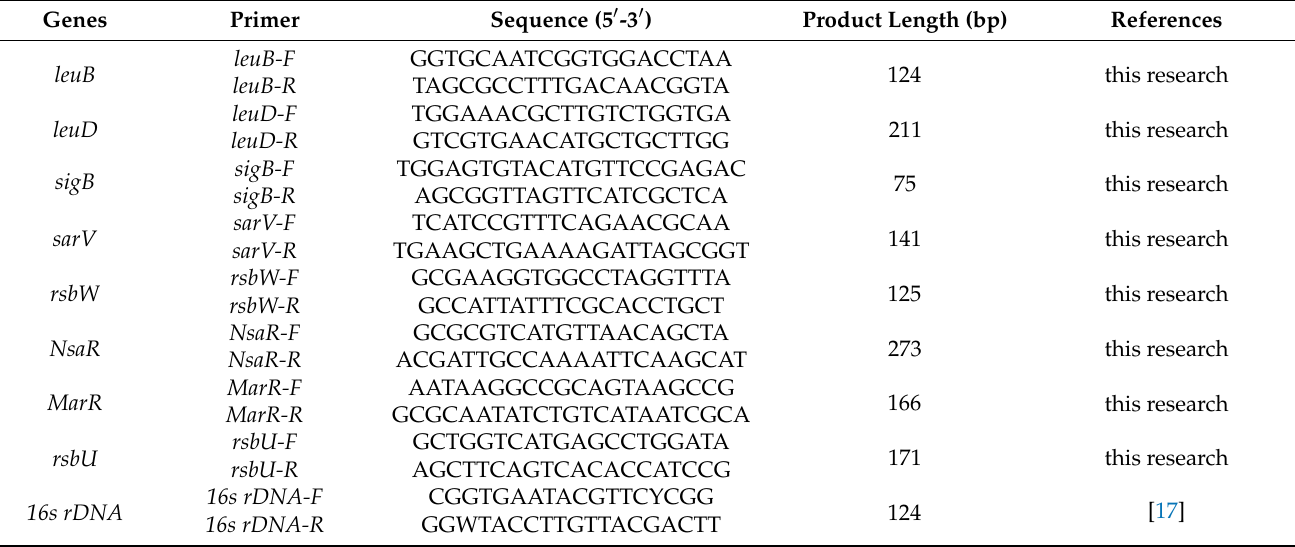
Table 1. Primers used for